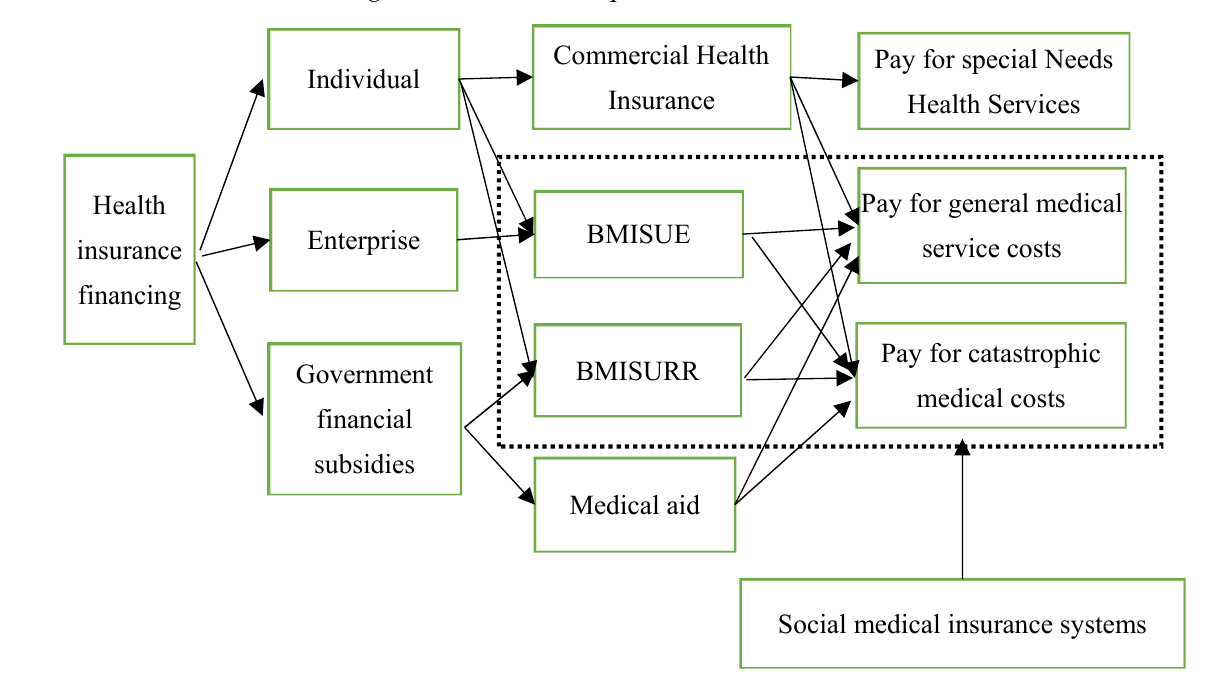
Figure 1. Framework of China’s medical insurance system.